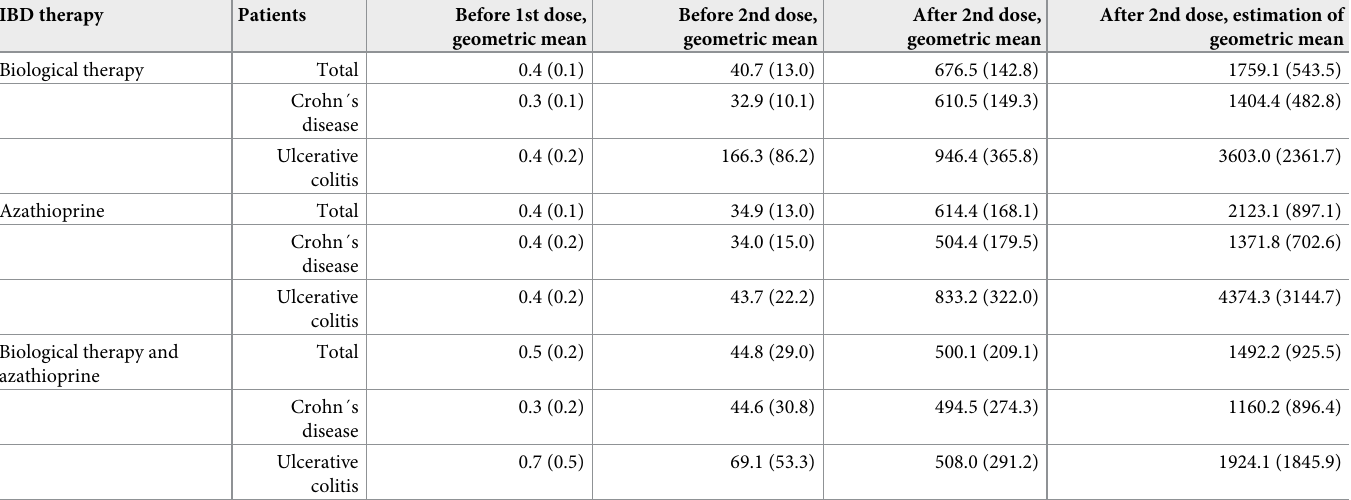
Table 2. Values of IgG antibodies against SARS-CoV-2 in 3 groups of patients, geometric means (standard errors). IBD